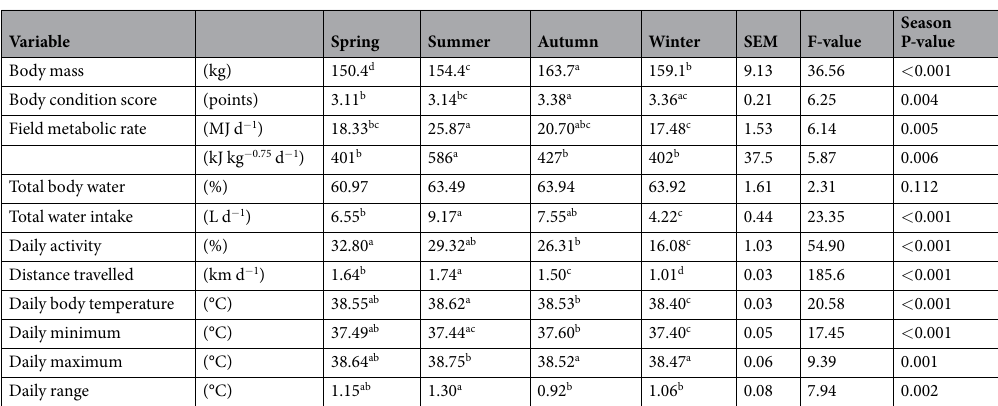
Table 2. Average physiological and behavioural variables in llama dams (n = 7) during two weeks at four different seasons (spring, summer, autumn and winter, see text for details) under central European climatic conditions. Values are LS-Means with the corresponding SEM, F- and P-value. a,b,c,d Means within a row not sharing the same superscript differ by P <